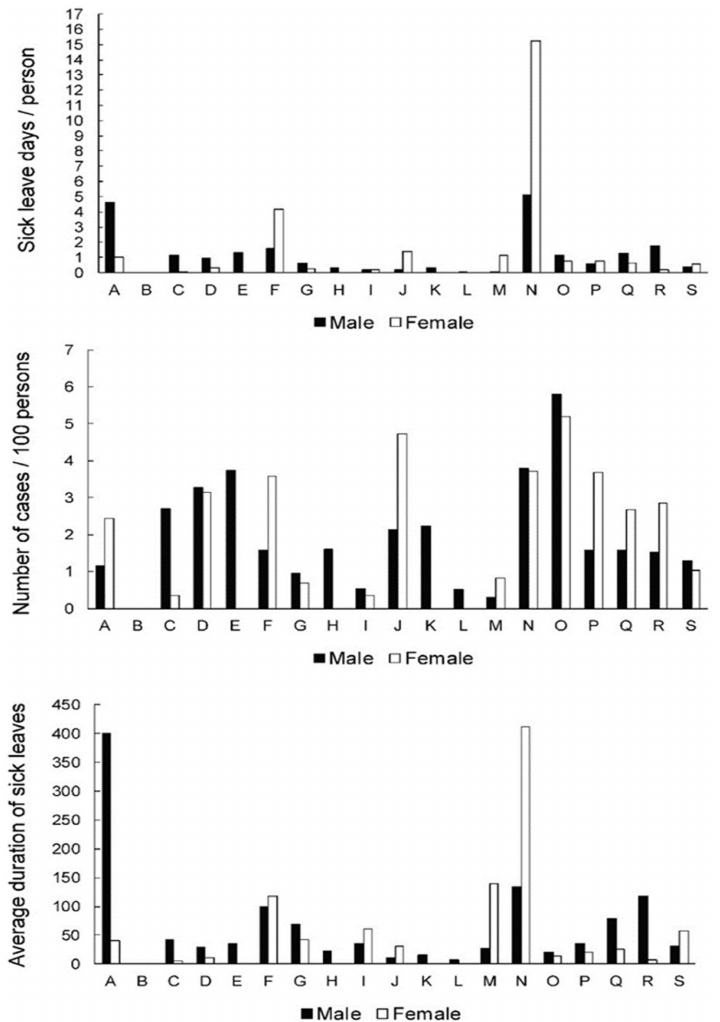
Figure 4. Sick leave days per person (index of temporary disability,) frequency of cases and sever- ity (average case duration) of sick leave across genders and activities in >65-year-old group.